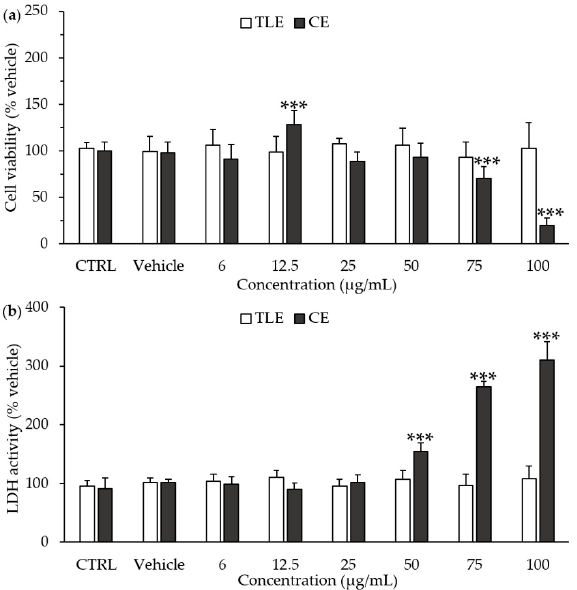
Figure 1. E ff ect of total lipophilic and carotenoid extracts from P. tricornutum on the cell viability and necrosis of HepG2 cells. The HepG2 cells were treated with the culture medium (control, CTRL), the vehicle (0.66% ethanol) or di ff erent concentrations of total lipophilic extract (TLE) and carotenoid extract (CE) from P. tricornutum (6–100 µg/mL) for 24 h, and cytotoxicity assays were performed. ( a ) Cell viability was evaluated by the MTT assay; ( b ) Necrosis of HepG2 cells was estimated by the measurement of extracellular lactate dehydrogenase (LDH) activity. Data are the means ± standard deviations from at least three independent experiments. Statistical significance was determined using ANOVA with post-hoc Fisher’s test and (an) asterisk(s) indicate significant difference compared to the vehicle with *** p < 0.001.